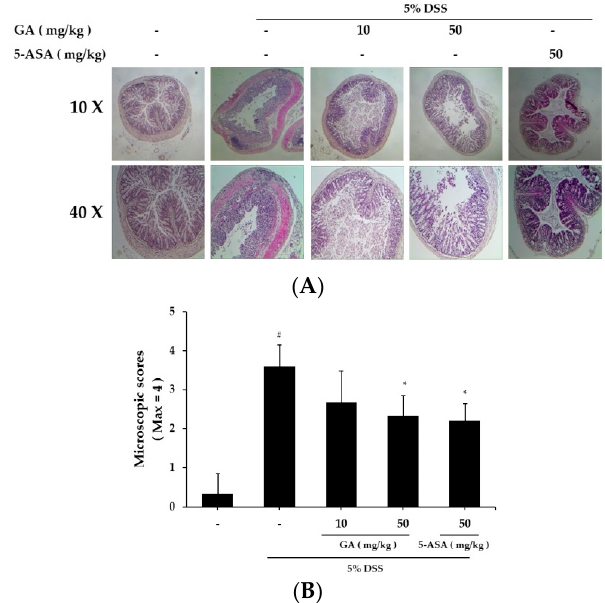
Figure 5. Effects of GA on epithelial injury in DSS-induced UC. ( A ) Paraffin sections of colonic tissue were stained with hematoxylin & eosin, and then observed by microscope (10× and 40×); ( B ) Microscopic scores. Values represent mean ± S.E.M. ( n = 6). Data were analyzed by Student’s t -test ( # p < 0.05 vs. control and * p < 0.05 vs. DSS alone).